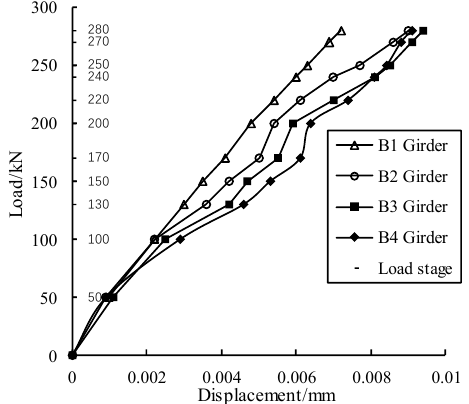
Buildings 2023 , 13 , x FOR PEER REVIEW Figure 6. Deformation curve at the midspan of girder specimens. Figure 6. Deformation curve at the midspan of girder specimens.